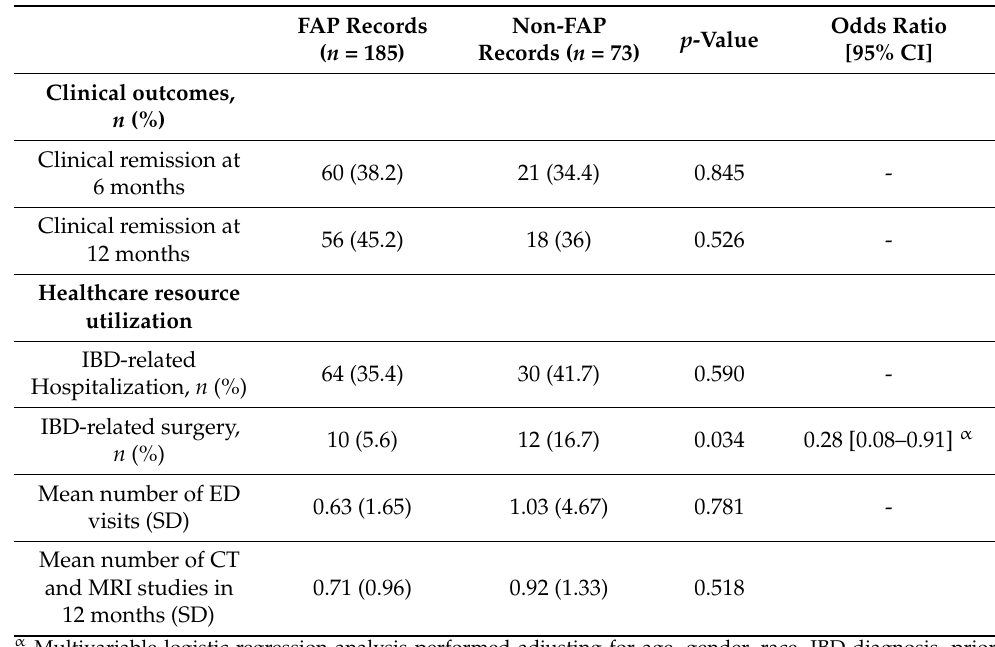
Table 3. Differences in outcomes and healthcare resource utilization between IBD records with and without financial assistance program ( n = number of unique biologic